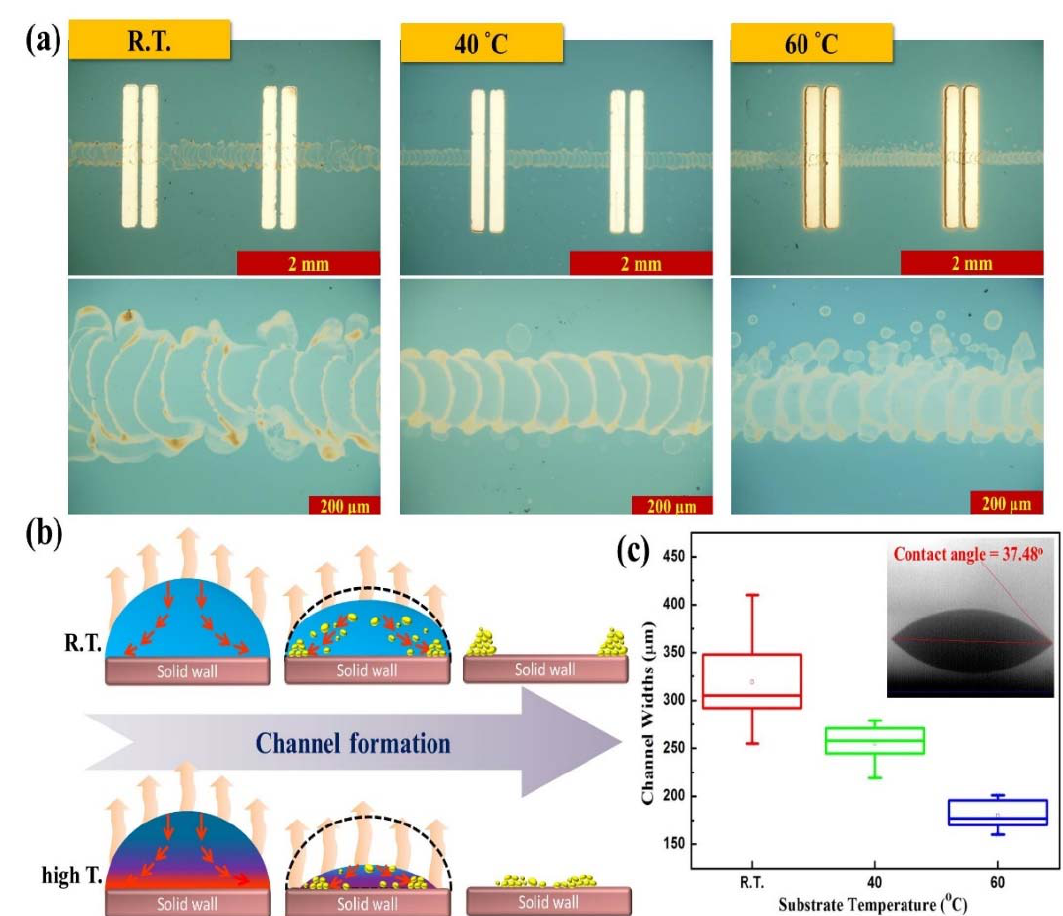
Figure 2. The 3-D semiconducting channel structure of ink-jet-printed ZnO-based TFTs. ( a ) Optical microscope (OM) images of the ZnO remaining on the substrate after the solution evaporation at di ff erent substrate temperature, optical magnification in ( × 4 / 0.13, top) and ( × 20 / 0.50, bottom), respectively. ( b ) Schematic diagrams of the evaporation phenomenon in a droplet at di ff erent temperatures: room temperature (top) and higher temperature (bottom). ( c ) The channel widths were normalized for 10 devices by an IJP droplet with the substrate temperature at room temperature, 40 ◦ C and 60 ◦ C, respectively. The inset shows the contact angle analysis of the dielectric layer, which was performed using a DI water